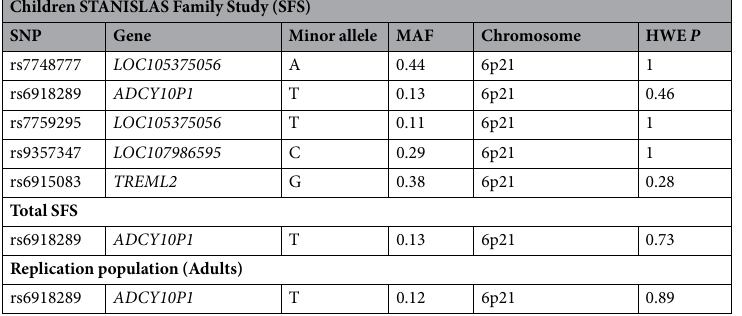
SFS Children SFS Total SFS with IMT-F Replication Population Sample size [% female] 139 [52.5%]